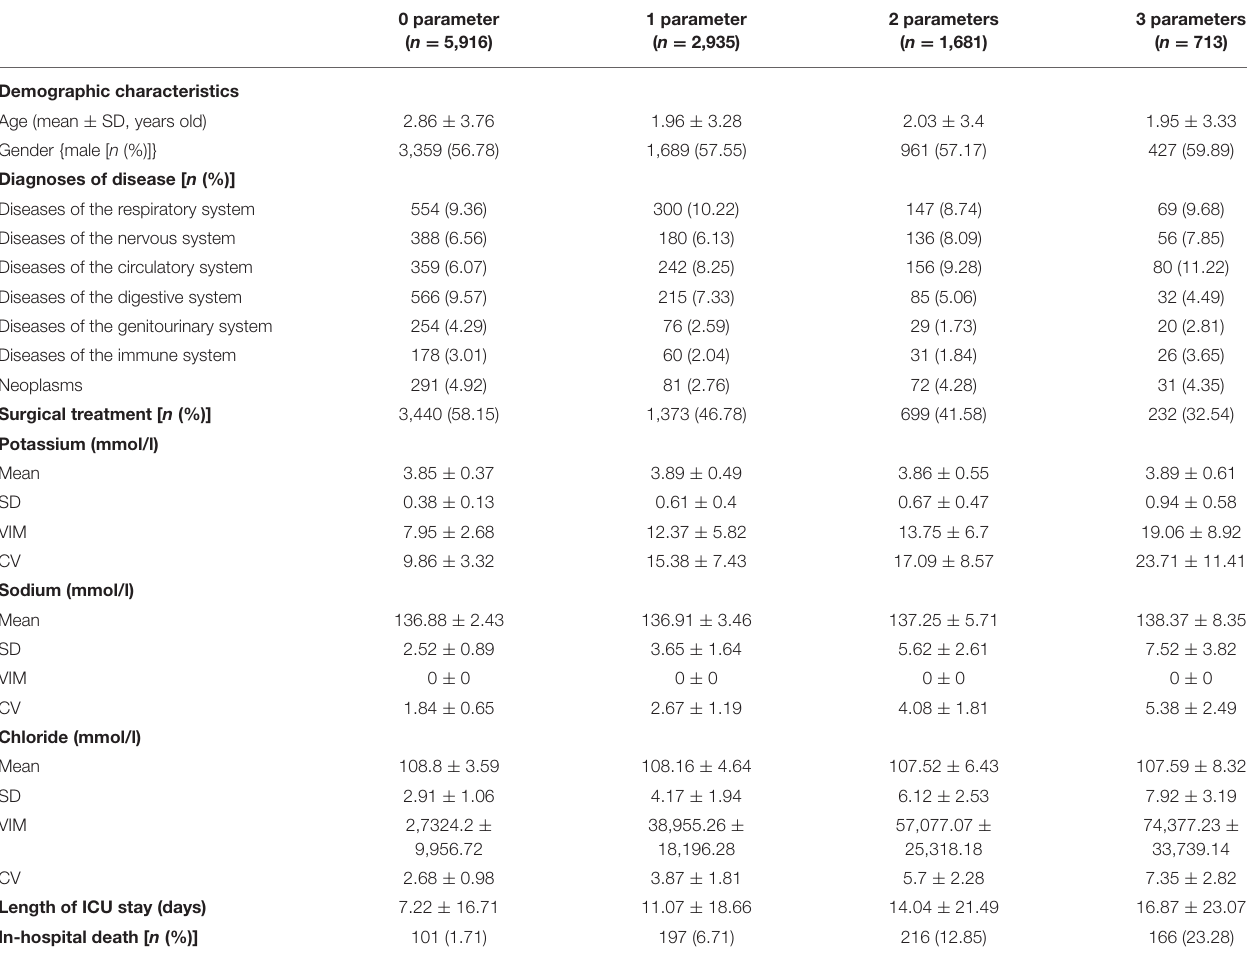
TABLE 1 | Characteristics of subjects according to number of parameters with high variability measured as coefficient of variation.